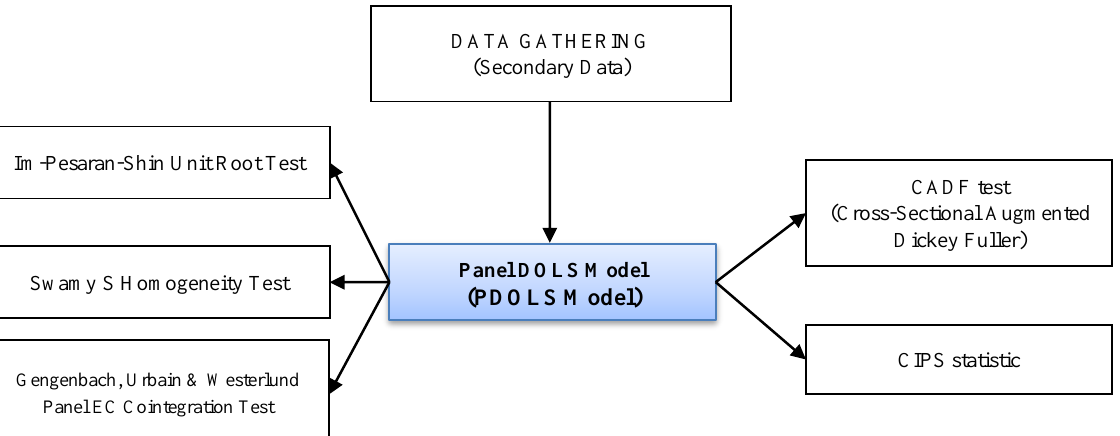
Figure 1. Flowchart of the research